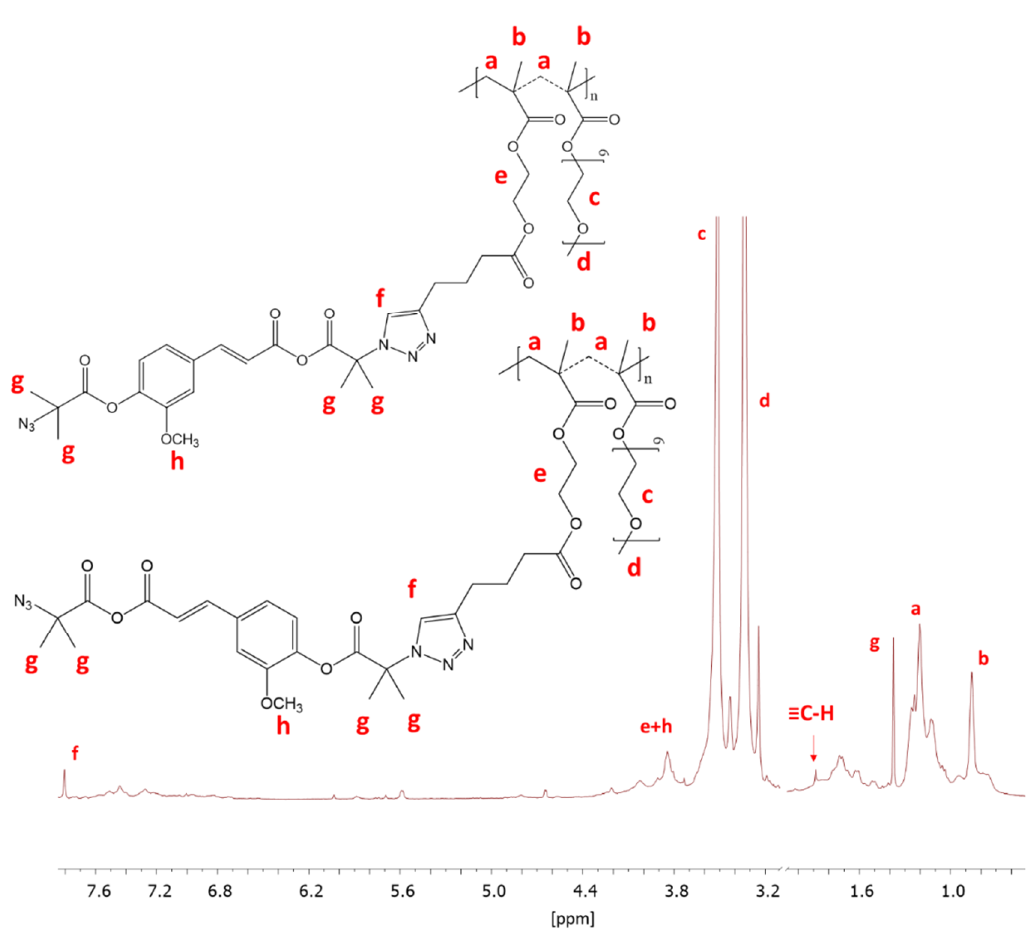
Figure 4. 1 H NMR of conjugated IV-FA.